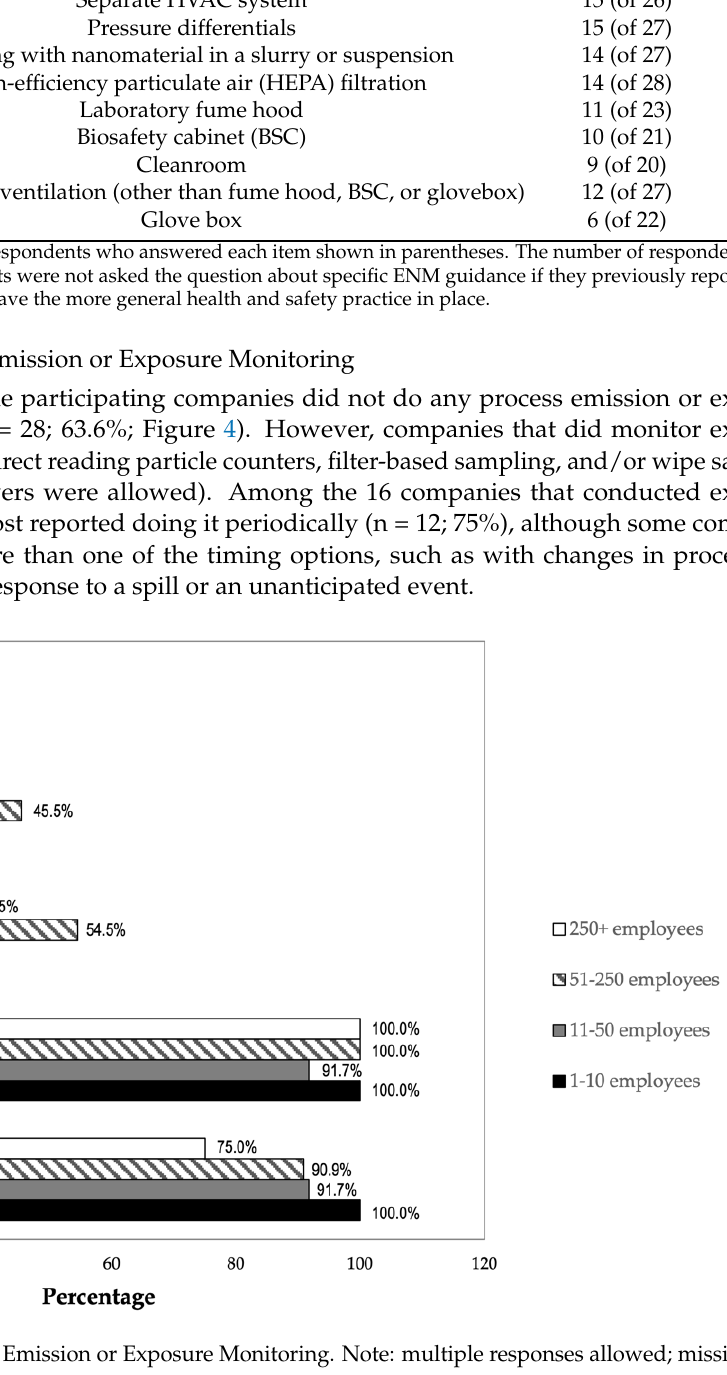
Figure 4. Process Emission or Exposure Monitoring. Note: multiple responses allowed; missing n =